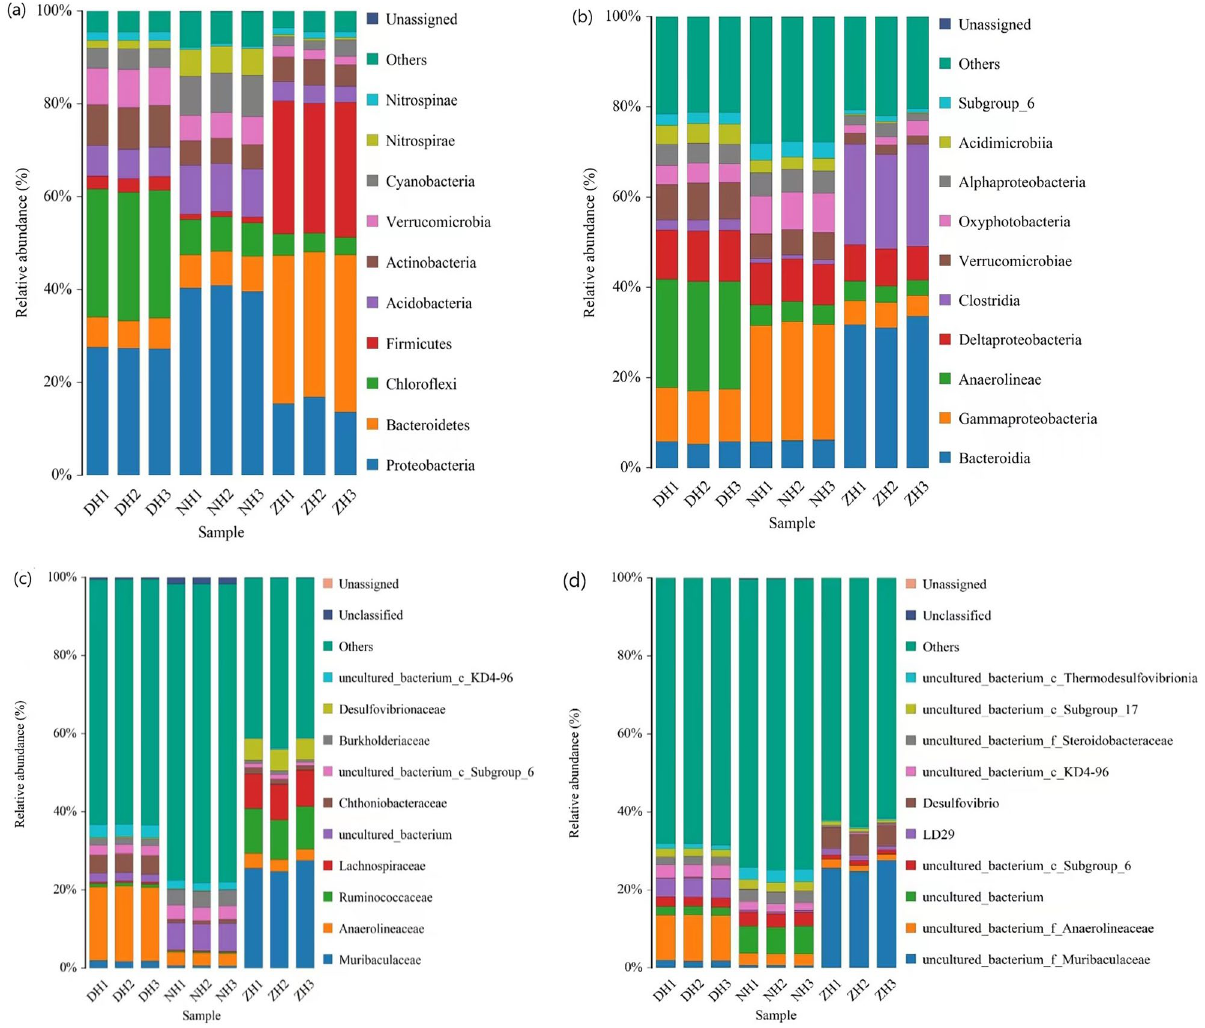
Figure 5. Relative abundance of dominant bacteria in surface sediments based on phylum, class, family, and genus